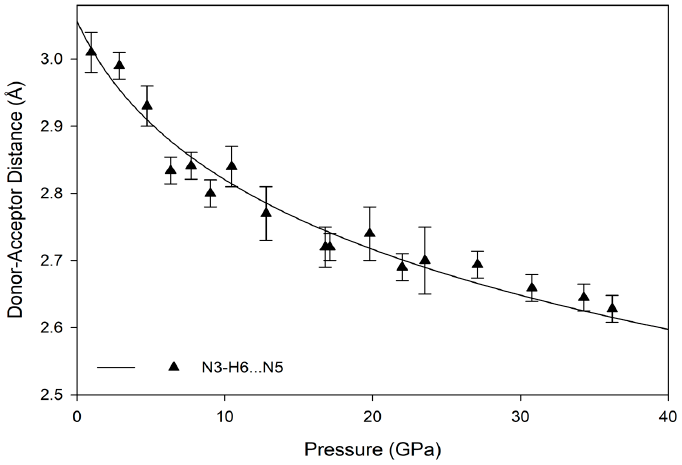
Figure 10. Inter-plane hydrogen bond D···A distance as a function of pressure, fitted with a third-order polynomial function.